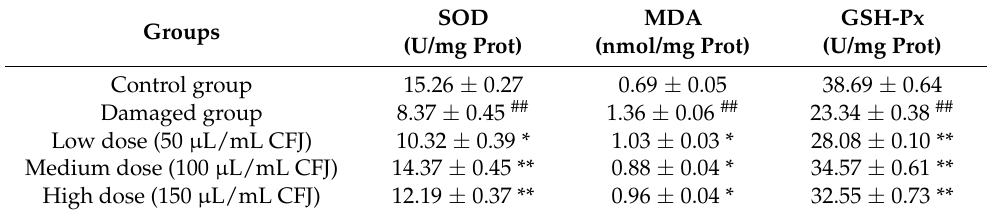
Table 7. Effects of CFJ on SOD activity, GSH-PX activity, and MDA contents in damaged cells. Groups